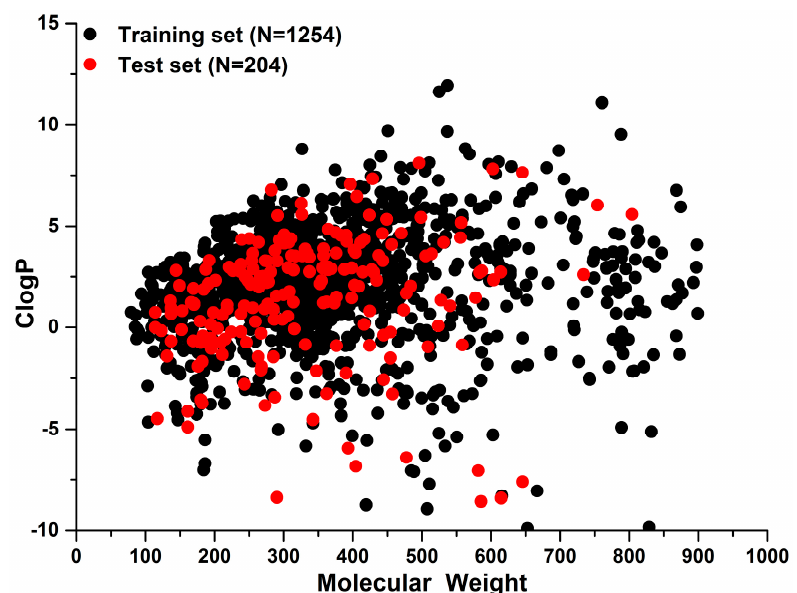
Figure 2. The distribution of training set and external test sets in the chemical space which was defined by molecular weight as X -axis and ClogP as Y -axis.